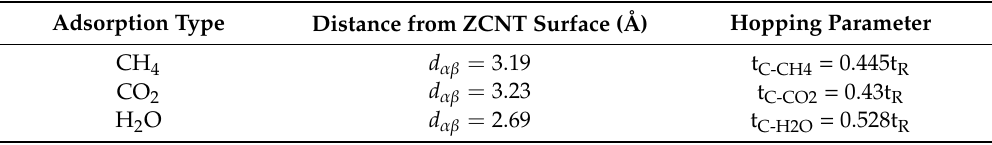
Table 1. The calculated hopping energies for adsorbed gas